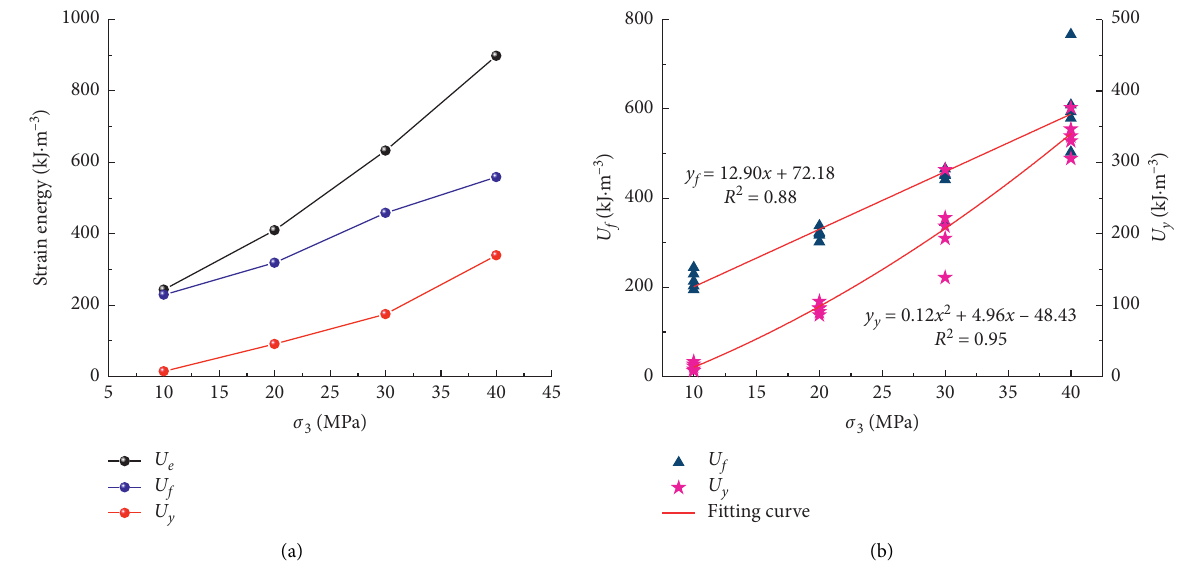
Figure 12: Energy variation characteristics of sandstone after unloading failure. (a) Energy transformation of sandstone after unloading failure under different initial confining pressure. (b) Fitting of postpeak failure energy, surplus energies and the initial confining pressure.